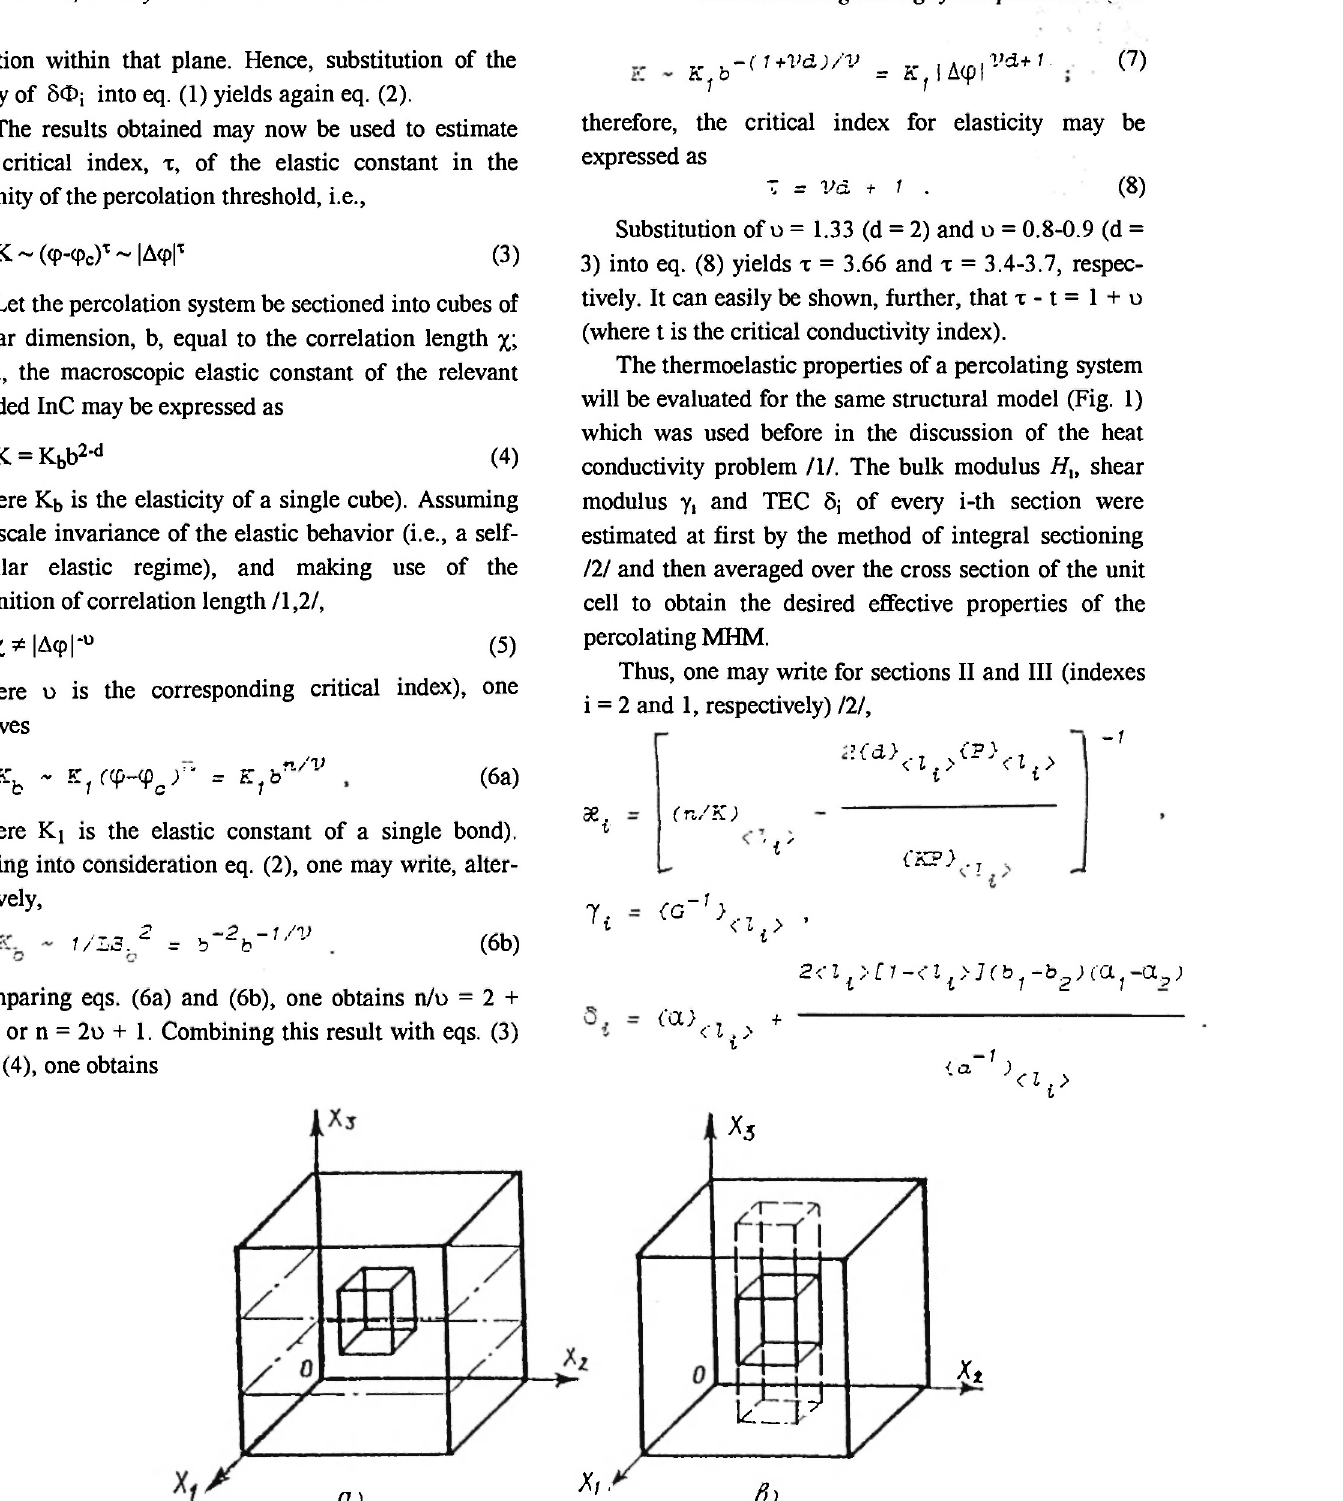
Sectioning of the "cube-in-cube"-type unit cell to estimate the upper (a) and lower (b) bounds of elasticity